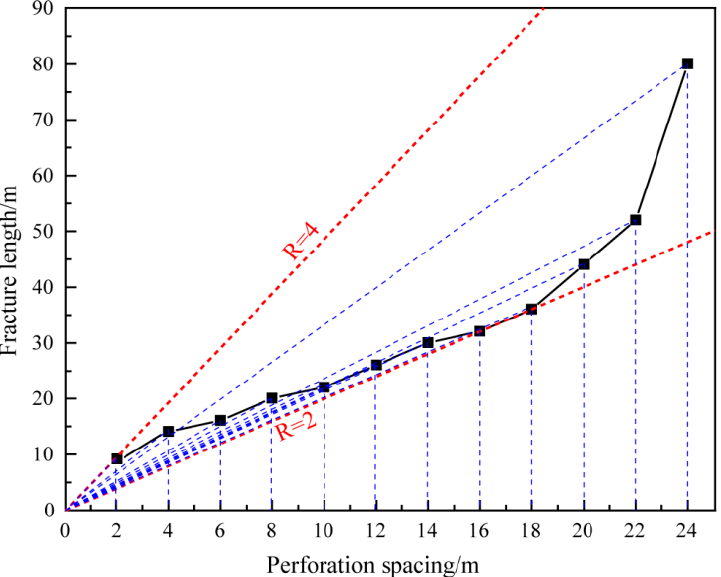
Figure 7. Fracture length with the strongest stress shadow effect under different perforation spacing. R represents the ratio of fracture length to perforation spacing. R has a strong concentration, mainly between 2 and 4.